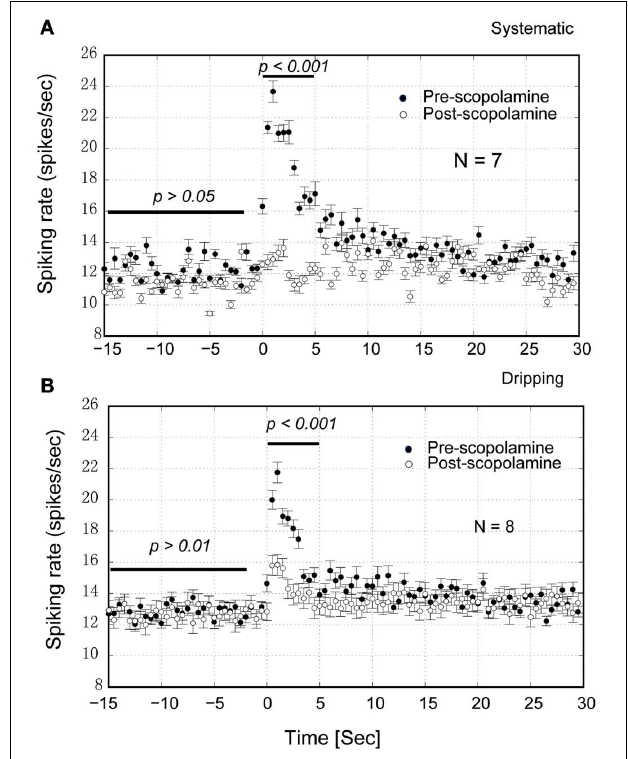
FIGURE 10 | Group statistics of the neurons show that scopolamine attenuates the NDB potentiation in the MOB. (A) IP injection of scopolamine blocked the NDB potentiation completely ( p < 0 . 001) but not the spontaneous activity ( p > 0 . 05). (B) Dripping scopolamine on the top of MOB attenuated the NDB potentiation significantly ( p < 0 . 001) without effect on the spontaneous activity ( p > 0 . 01). Horizontal bar indicates the paired samples used for